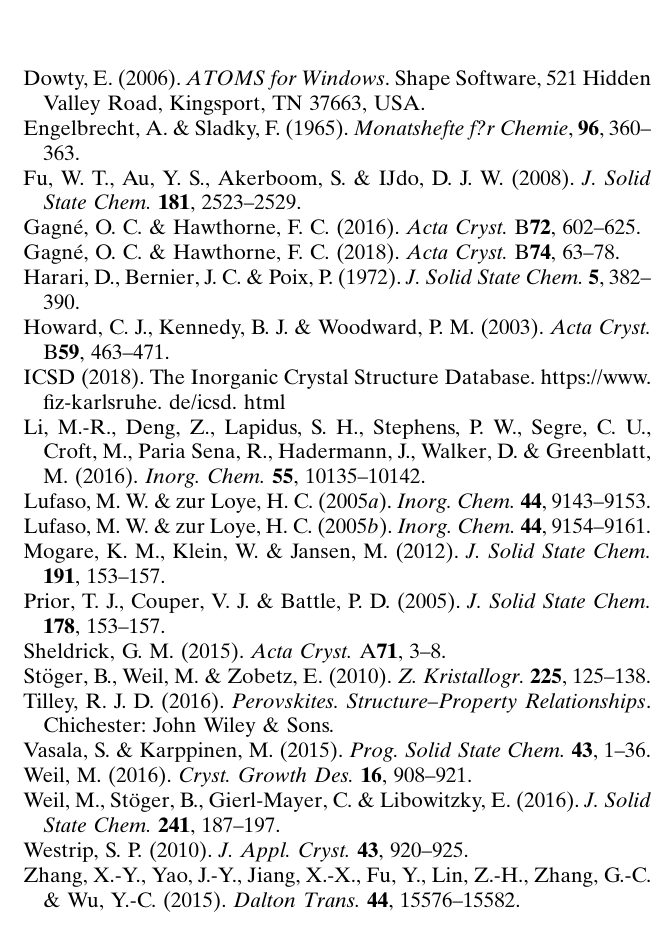
Crystal data Chemical